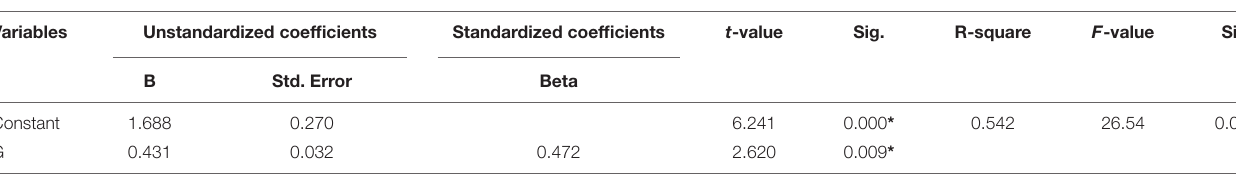
TABLE 3 | Results of the regression equation.